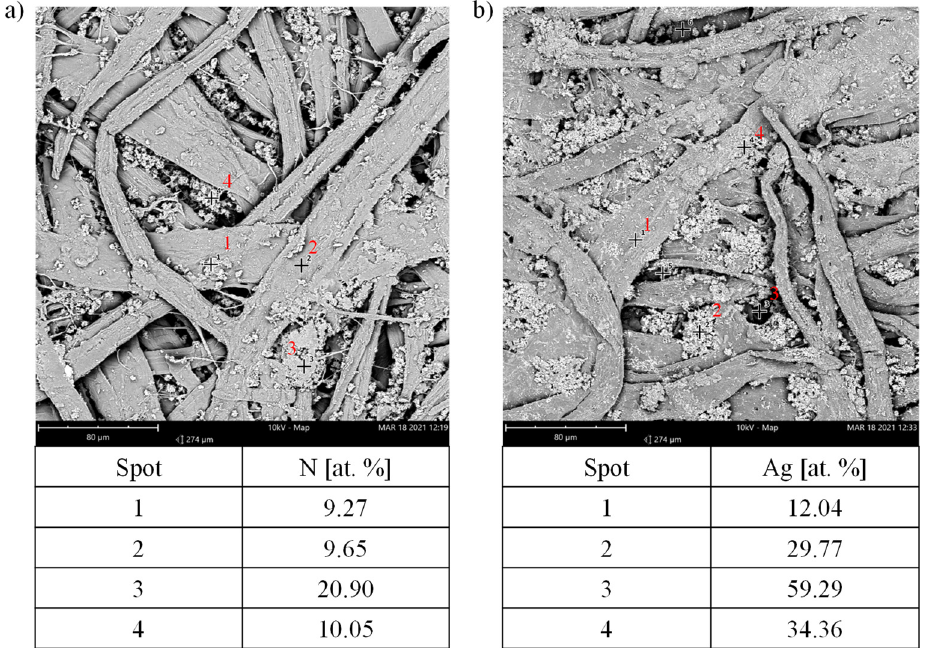
Figure 4. EDS surface point analysis of the ( a ) PD and ( b ) PAg samples .